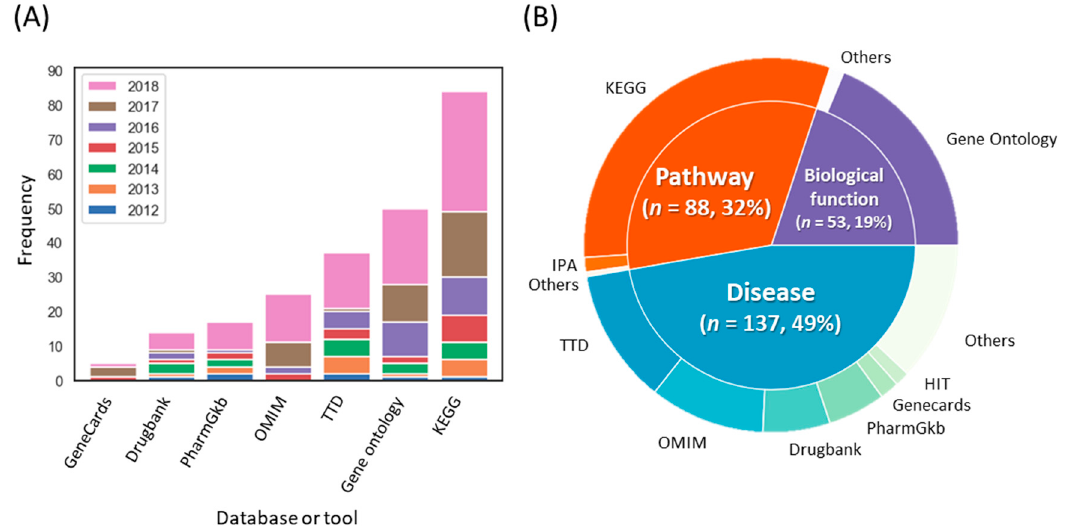
Figure 6. Trends in the biomedical databases used for target interpretation. ( A ) The frequencies of databases used for target interpretation. ( B ) Categories of databases and their composition. The outer circle and inner circle represent the databases used for target interpretation and their categories, respectively. Note that THM-NP studies in 2011 were excluded from the visualization due to their low frequency ( n = 2). KEGG, Kyoto Encyclopedia of Genes and Genomes; TTD, Therapeutic Target Database; OMIM, Online Mendelian Inheritance in Man; IPA, Ingenuity Pathway Analysis.